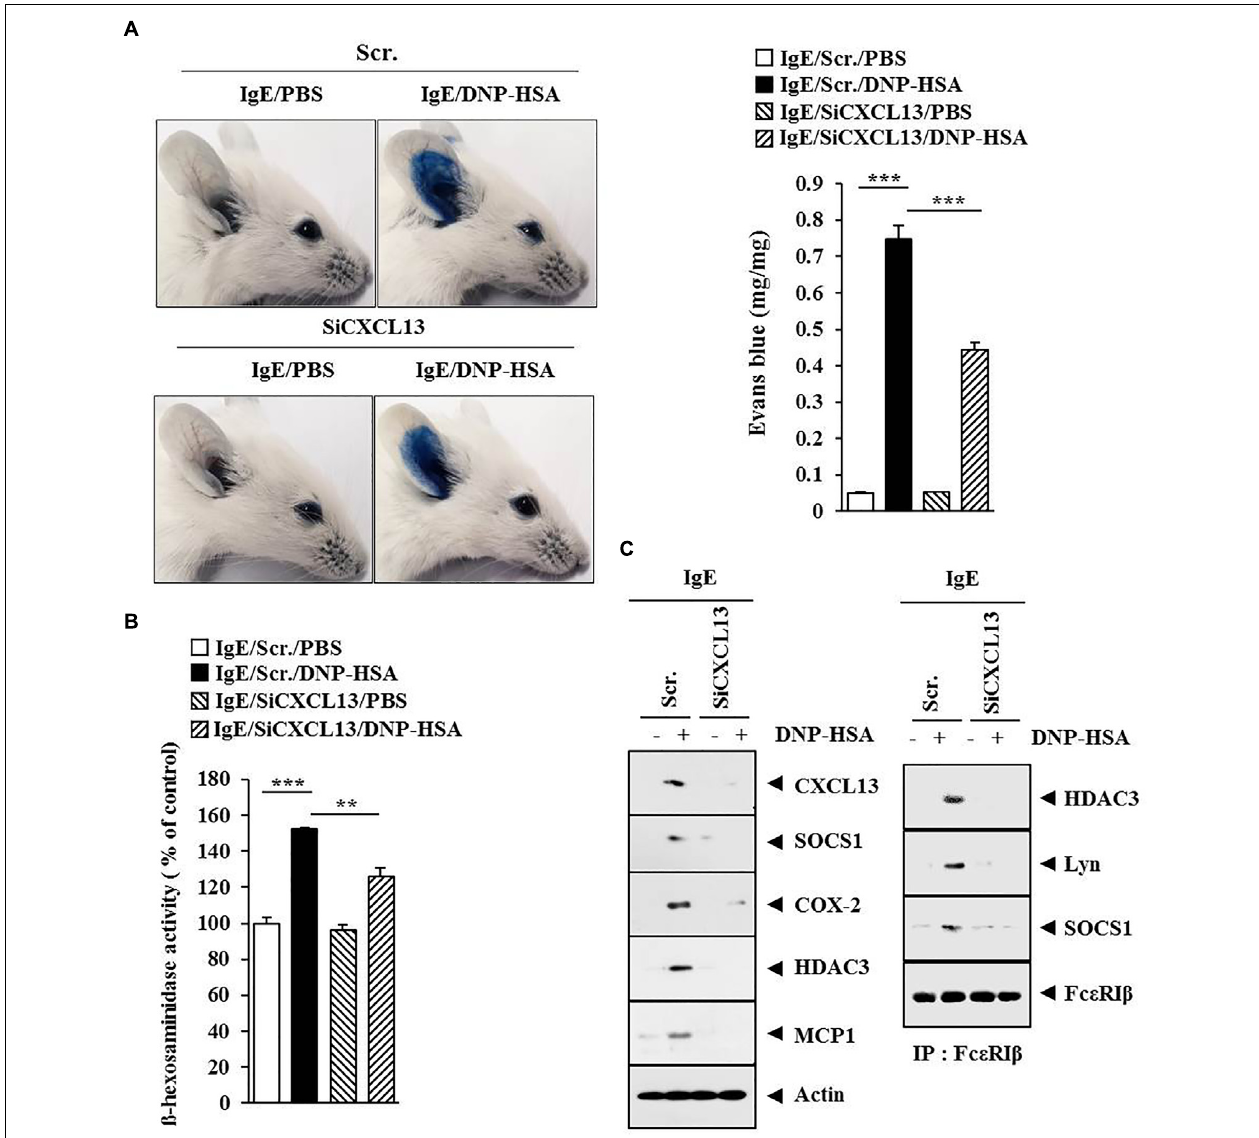
FIGURE 12 | CXCL13 mediates passive cutaneous anaphylaxis. (A) Passive cutaneous anaphylaxis was performed as described. After 1 h of Evans blue solution injection, the dye was eluted from the ear in 700 µ l of formamide at 63 ◦ C. The absorbance was measured at 620 nm. Representative images from four animals of each experimental group are shown. ∗∗∗ p < 0.0005. (B) Ear tissue lysates from BALB/c mouse of each experimental group were subjected to β -hexosaminidase activity assay. ∗∗ p < 0.005; ∗∗∗ p < 0.0005. (C) Same as (B) except that western blot and immunoprecipitation were